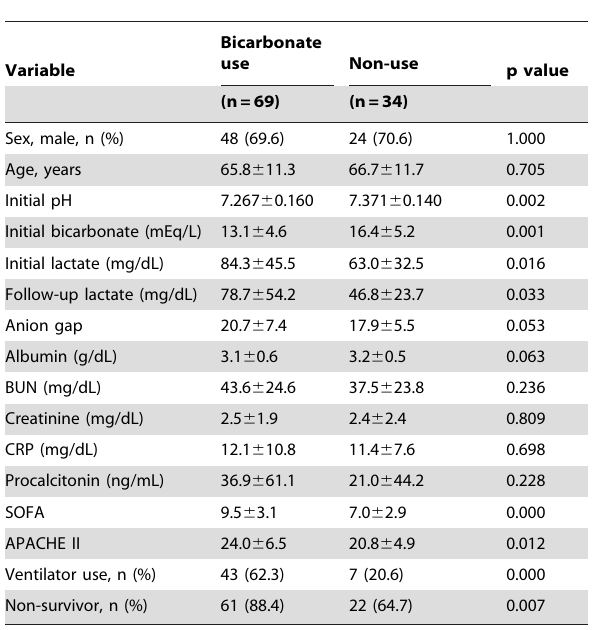
Table 2. Patient characteristics according to sodium bicarbonate administration (n= 103).